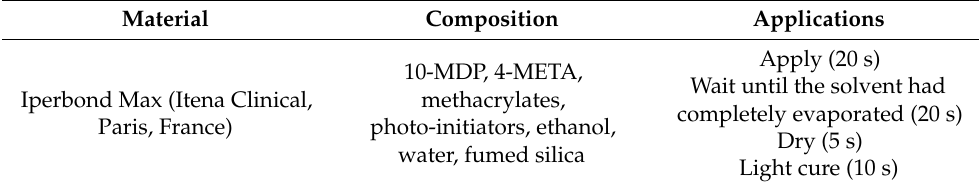
Table 1. Universal adhesive, chemical composition, application process, and